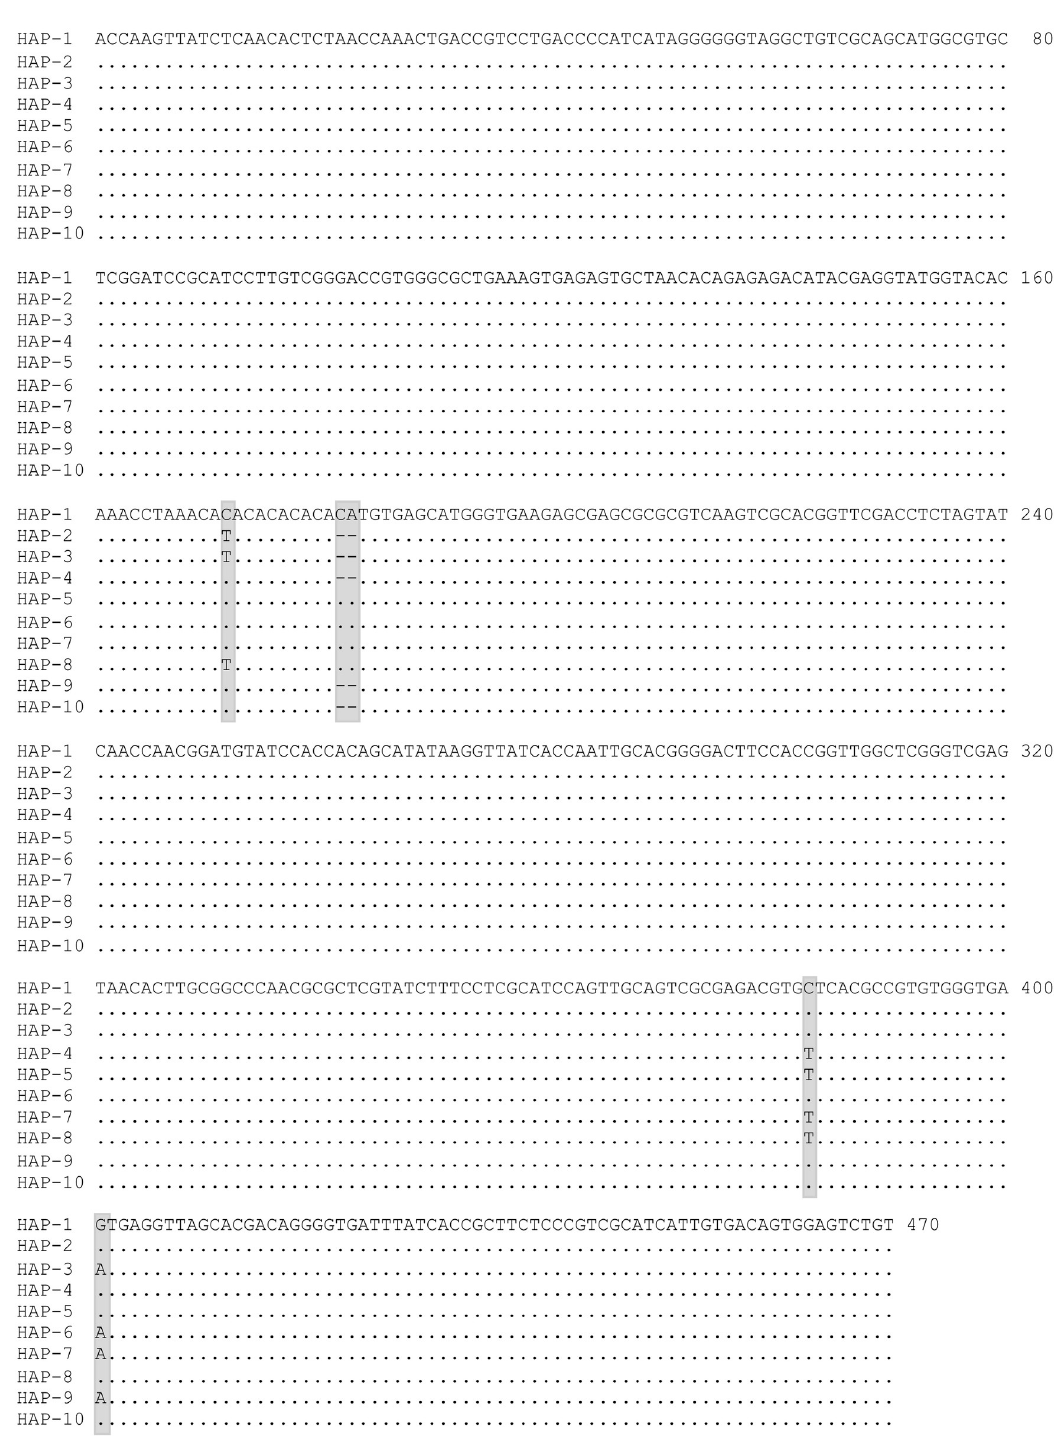
Fig 2. Alignment of haplotypes of complete ITS2 sequence of An . stephensi (the flanking 5.8S and 28S rDNA sequences are not shown here). The polymorphic loci have been highlighted (SNPs at three base positions, i.e., 172, 383 and 401; two bp indel at base positions 182–183). Dot represents similarity with Hap-1 sequence and dash represents gap in nucleotide sequence.